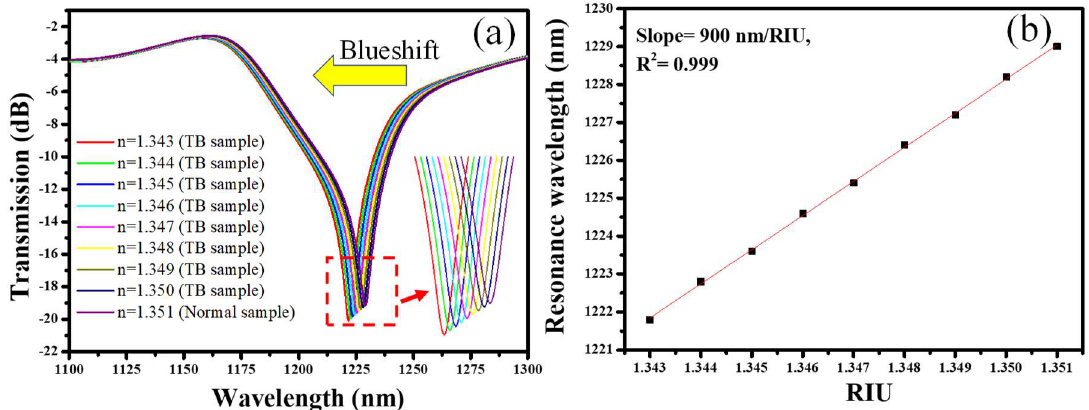
Figure 4. Sensing performance; ( a ) transmission spectrum of the sensor in the presence of normal and TB-infected blood plasma; ( b ) resonance wavelength versus RIU.